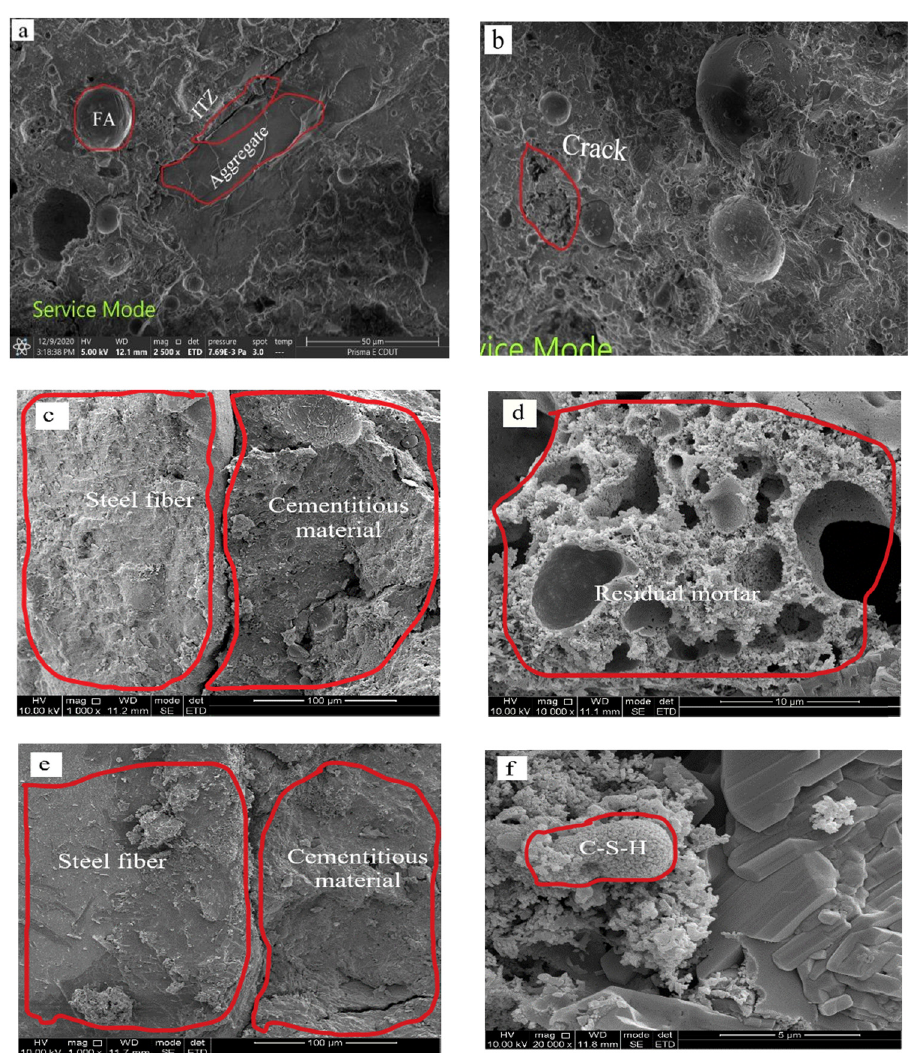
Figure 21: SEM analysisresults: ( a ) M testgroup interface; ( b ) microcracks; ( c ) bonding between steel fi ber and cementitiousmaterialinSF - 2.0 test group; ( d ) residual mortar; ( e ) bonding between steel fi ber and cementitious material in SF - 2.5 test group; ( f ) distribution of C – S – H